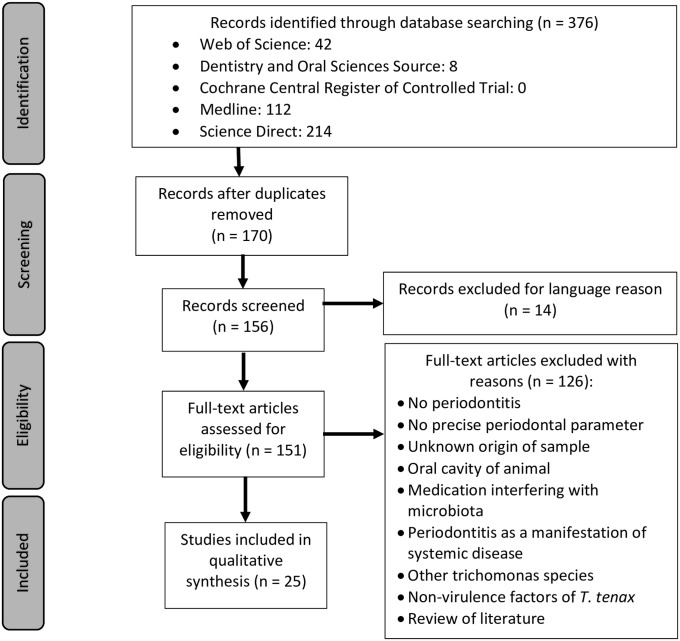
Study flow diagram.